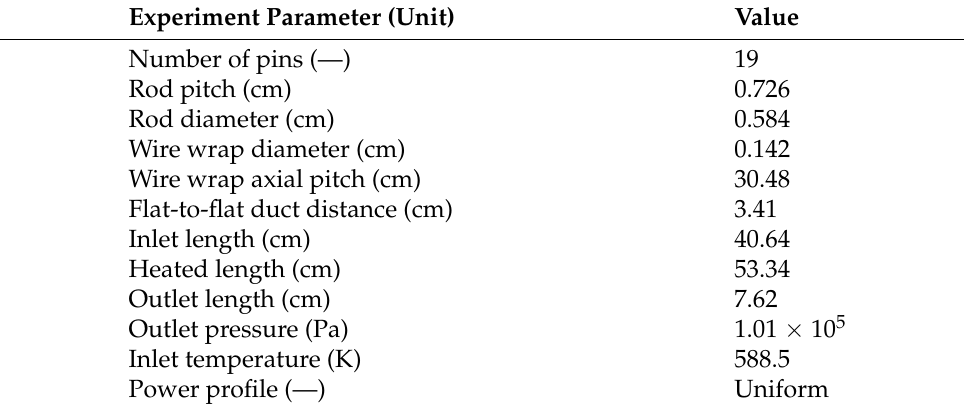
Table 3. Design and operational parameters for ORNL’s 19-pin